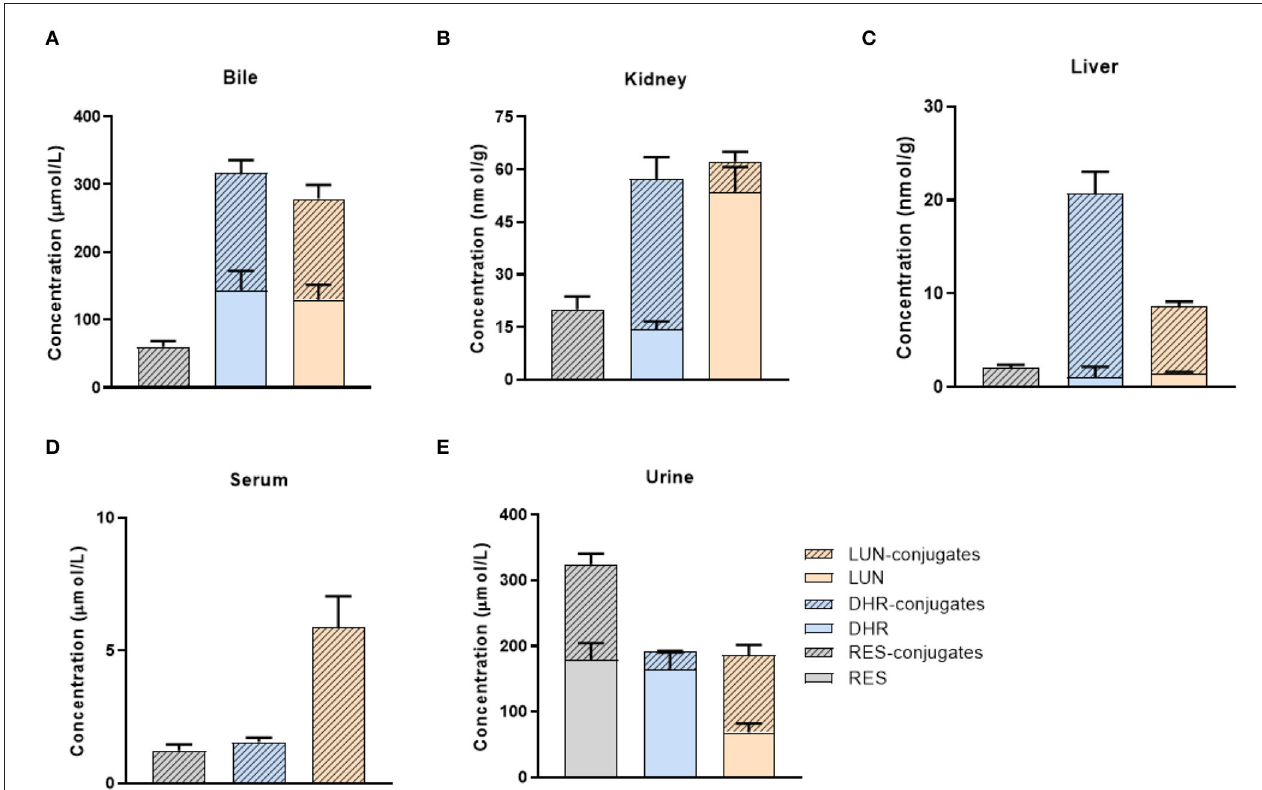
FIGURE 2 | Tissue distribution of RES metabolites. Concentrations of RES, DHR, LUN, and their conjugates in the bile (A) , kidney (B) , liver (C) , serum (D) , and urine (E)